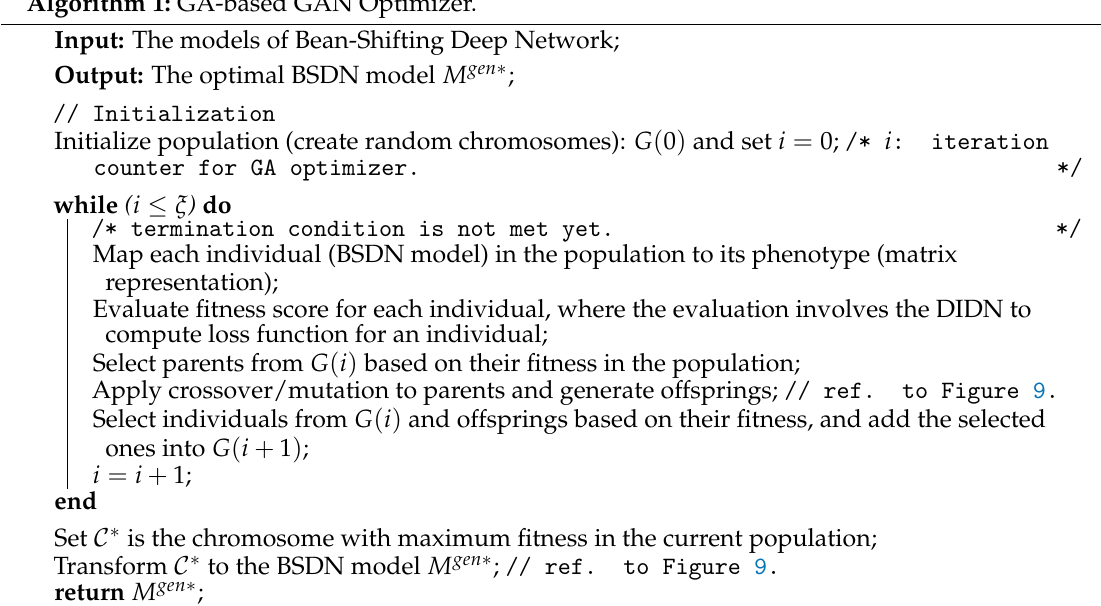
Algorithm 1: GA-based GAN